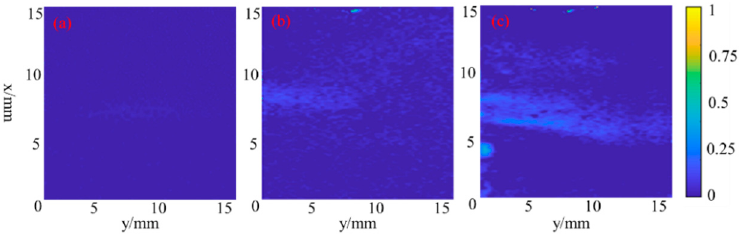
Figure 6. The cavitation intensity distribution of hydrodynamic-acoustic cavitation under the inlet pressure of 1.5 MPa ( a ) Without ultrasound ( b ) 250 W ( c ) 500 W.